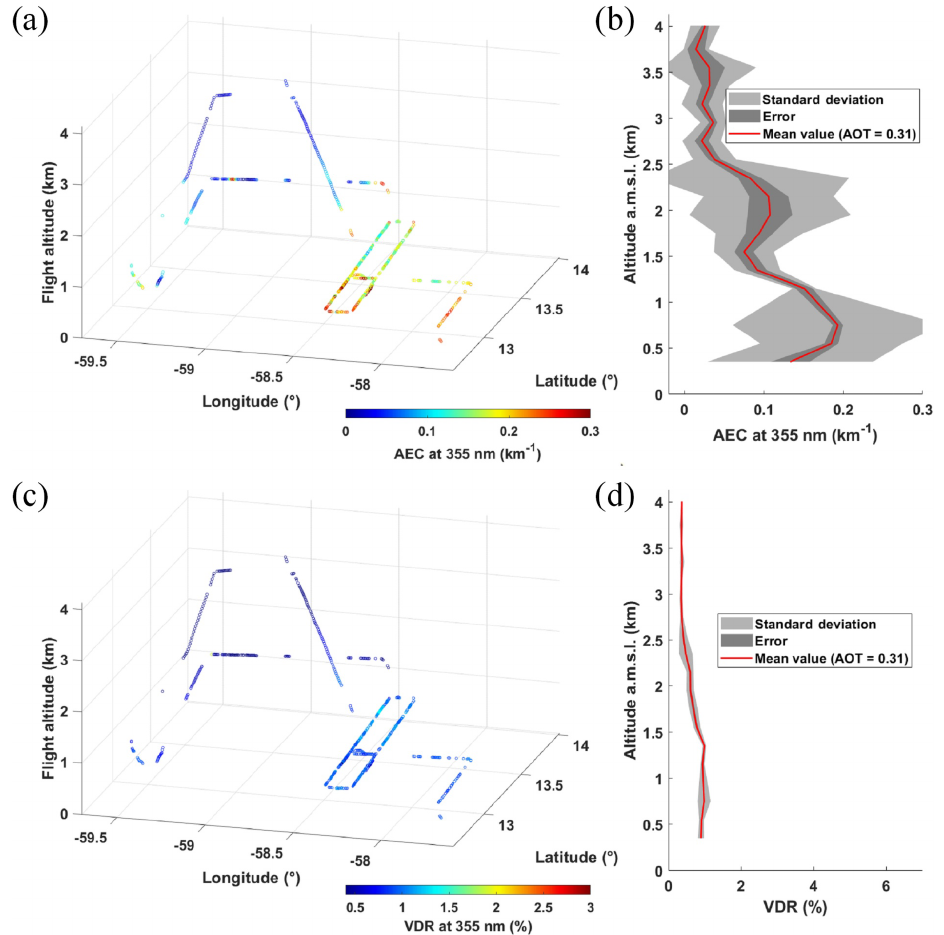
Figure 4. Same as Fig. 1 during flight F18 on 11 February 2020 at 11:30–16:00UTC.